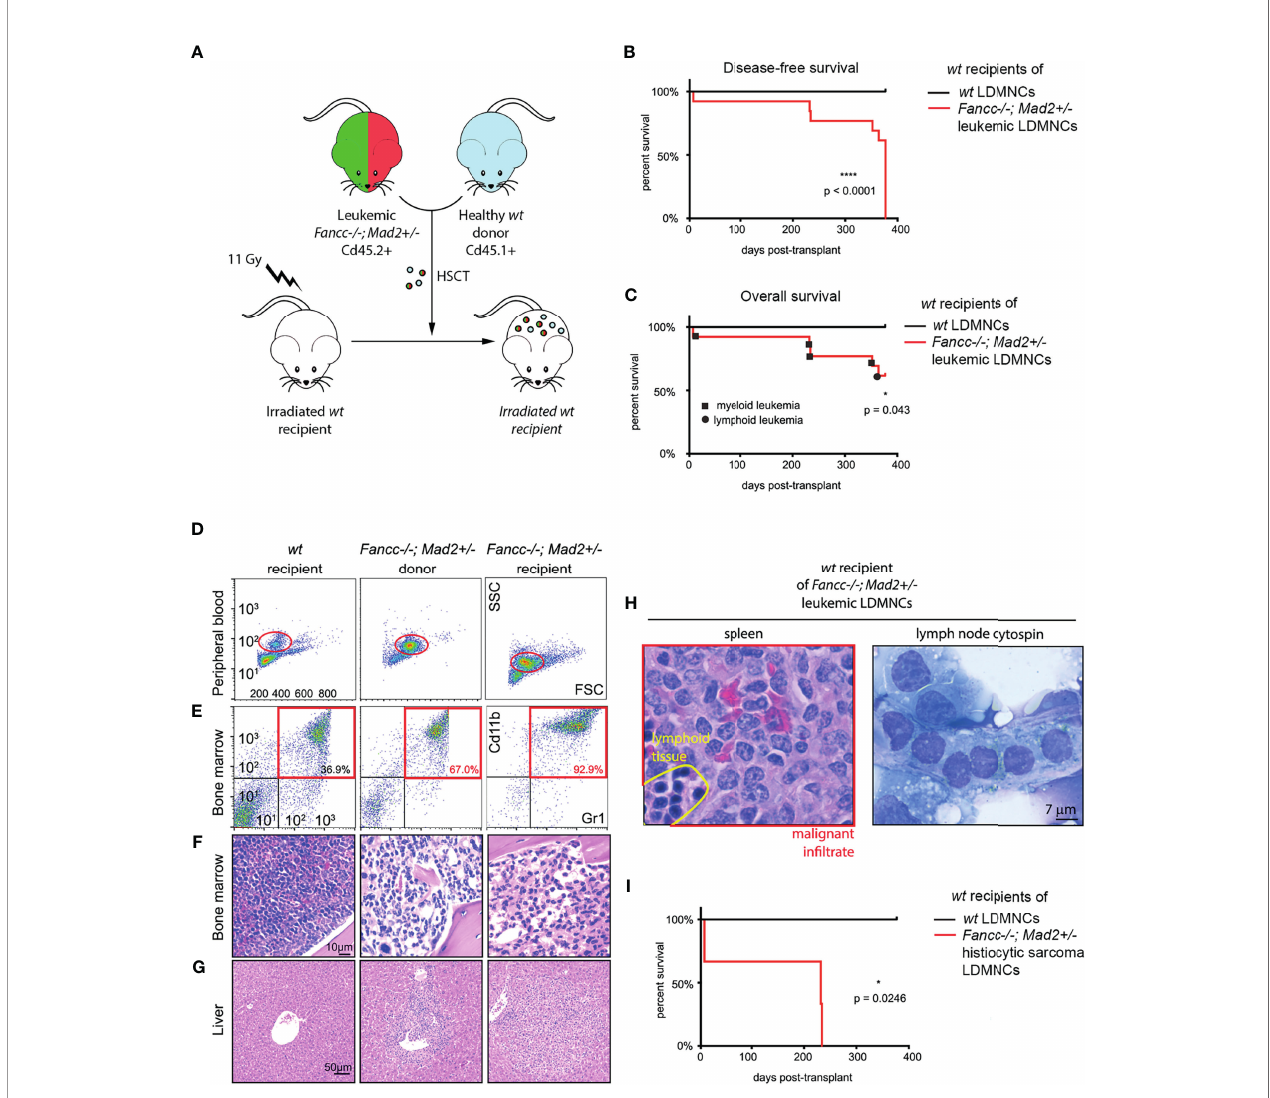
FIGURE 2 | Lethal hematopoietic malignancy in wt mice transplanted with marrows of moribund Fancc-/-; Mad2+/- mice. (A) Experimental design of competitive hematopoietic cell transplantation. (B) Disease-free survival (p<0.0001) and (C) overall survival (p=0.043) of wt recipients transplanted with bone marrows of indicated genotypes, n =8 recipients of wt donor marrow and n=13 recipients of marrow from leukemic Fancc-/-; Mad2+/- donors. Statistical signi fi cance was calculated via log-rank Kaplan-Meier Mantel-Cox tests. (D – G) Comparison of peripheral blood and marrow fl ow cytometry, bone marrow and liver morphology in a wt mouse, Fancc-/-; Mad2+/- donor and wt recipient of Fancc-/-; Mad2+/- marrow. (D, E) Myeloid marker fl ow cytometry, (F) evaluation of bone marrow architecture and (G) liver in fi ltrates demonstrating similar immunophenotype and histopathologic fi ndings in leukemic donor and recipients. (H) Malignant cell in fi ltration of lymph nodes and spleen in a representative moribund transplant recipient. (I) Survival of three recipient mice transplanted with bone marrow from a Fancc-/-; Mad2+/- donor mouse (p=0.0246). Statistical signi fi cance was determined with log-rank Kaplan-Meier Mantel-Cox tests. *p < 0.05, ****p <